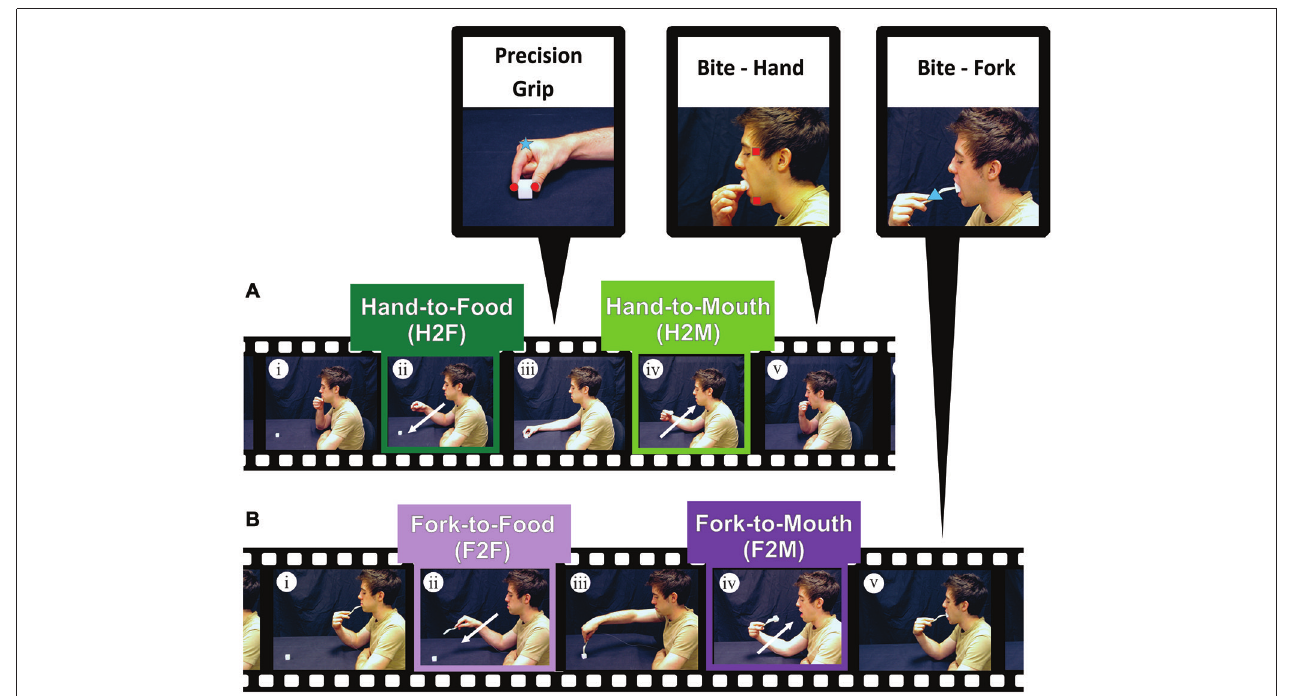
FIGURE 1 | Experimental procedure. (A) Experiment 1. Participants began Hand-to-Food reaches with their right index finger and thumb in a closed pinch position, resting on their chin (i) . Participants then reached out toward a cube of cheese (ii) and grasped it with a precision grip (iii) . Once the food item was within the participant’s grasp, an inwardly directed reach toward the mouth ( Hand-to-Mouth ) was performed (iv) , ending the reach with a precision bite using the upper and lower incisor teeth (v) . (B) Experiment 2. Participants performed the same movement as (A) except that instead of using the index finger and thumb to capture and transport the food item, a fork was used to pierce the cheese and bring it to the mouth to bite (i–v) . Zoomed views at the top of the figure show the placement of markers (infrared-emitting diodes, IREDs) on the index finger and thumb (red circles; to measure hand aperture), on the temple and lower jaw (red squares; to measure mouth aperture), and on the hand or fork (blue square and blue triangle respectively; to measure transport